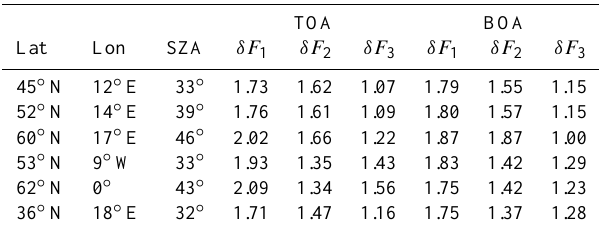
Table 1. Ratios of SW radiative impacts δF (as explained in the text) at TOA and BOA at six different locations. Also shown are the solar zenith angles (SZA) at